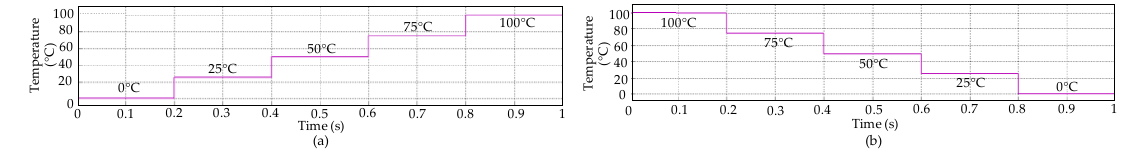
Figure 18. ( a ) Increases in temperature; ( b ) Decreases in temperature.